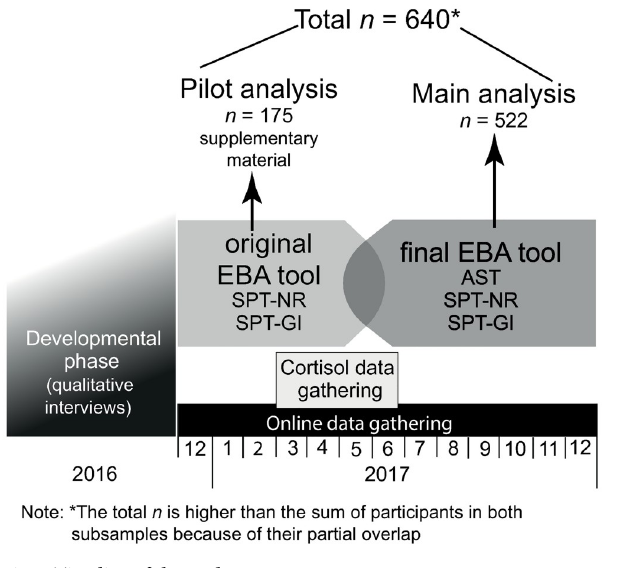
Fig 1. Timeline of the